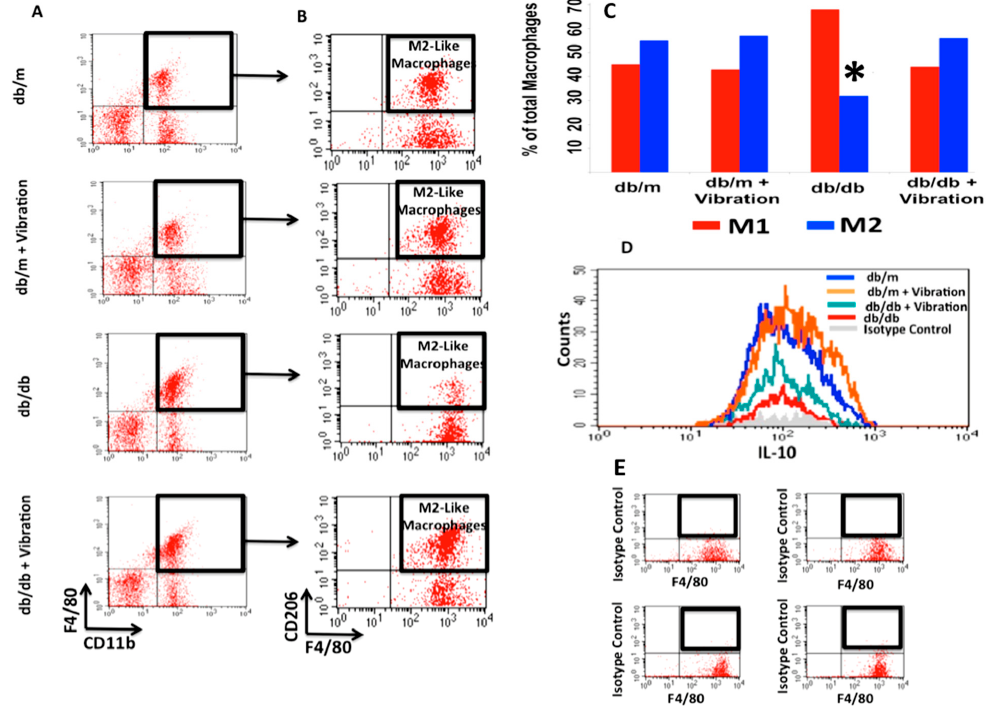
Figure 1. Whole Body Vibration (WBV) skews macrophage polarization from pro-inflammatory (M1) to anti-inflammatory (M2) in adipose tissue. Panels ( A ) and ( B ) show the flow cytometry analysis